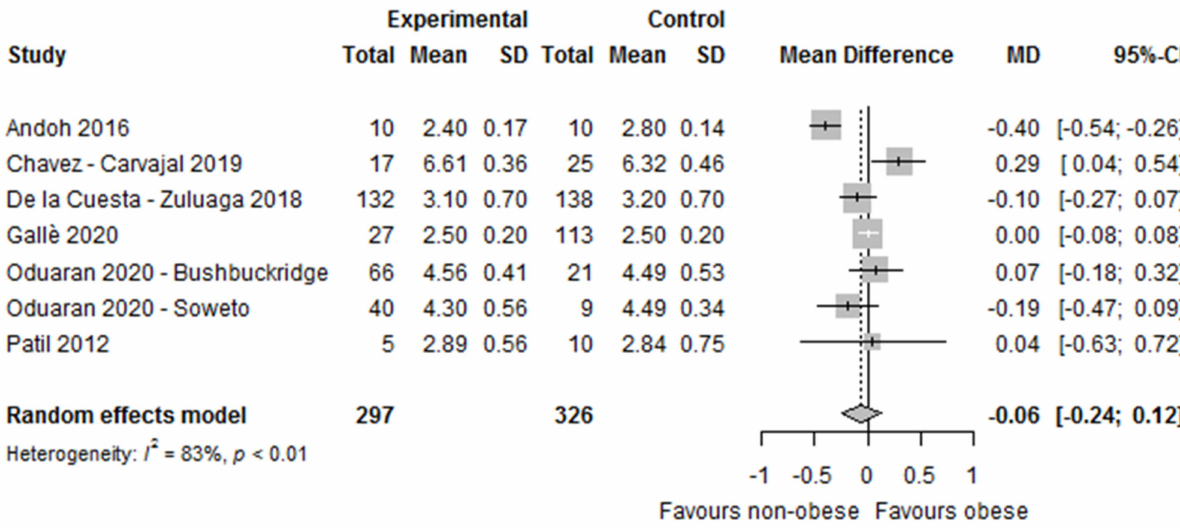
Figure 4. Forest plot of the differences in alpha diversity between obese and non-obese persons by Shannon index. Study references: Andoh et al. [17], Chavez-Carvajal et al. [19], De la Cuesta— Zuluaga et al. [41], Gall è et al. [45], Oduaran et al. [34], and Patil et al.